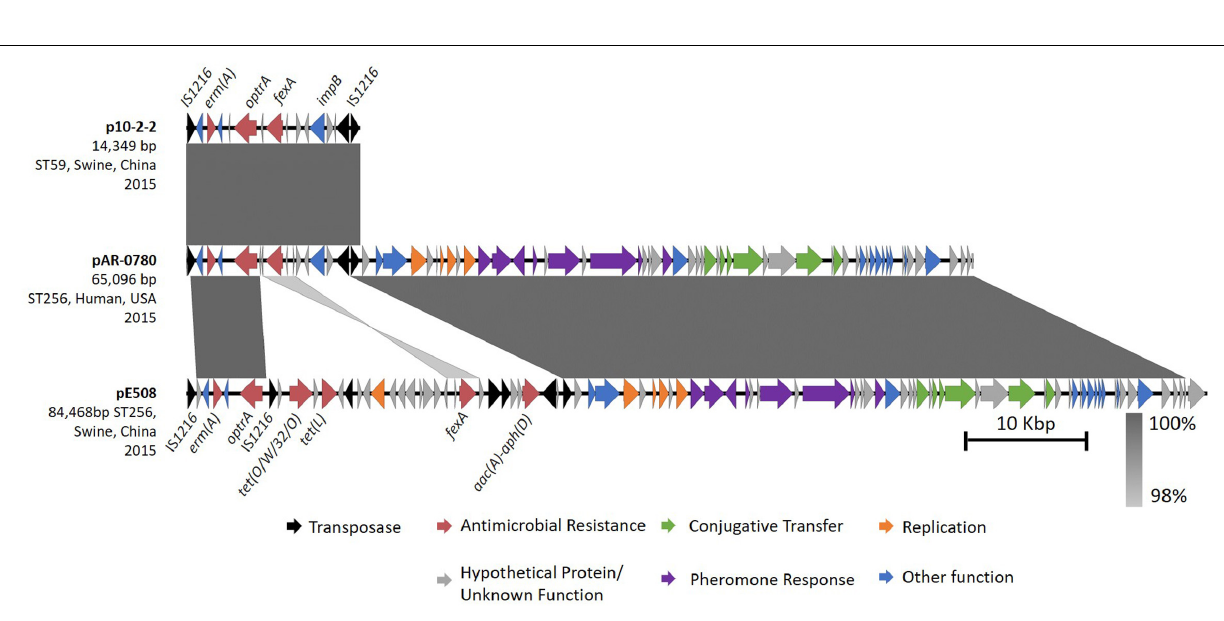
FIGURE 3 | Comparative analysis of pAR-0780 with similar optrA -encoding plasmids. pAR-0780 contained a near identical copy (100% query coverage, 99.95% identity) of a 14,349 bp optrA gene cluster flanked on the left- and right-hand sides by IS 1216 R elements (black) previously described on plasmid p10-2-2 from an E. faecalis isolate (ST59) recovered from a pig in China in 2015. The remaining 51,543 bp of pAR-0780 was nearly identical (100% coverage, 99.88% identity) to a 51,543 region of the 84,468 bp plasmid, pE508, a pheromone-responsive conjugative multiresistance plasmid from E. faecalis strain E508 (ST256), isolated from a swine fecal sample in